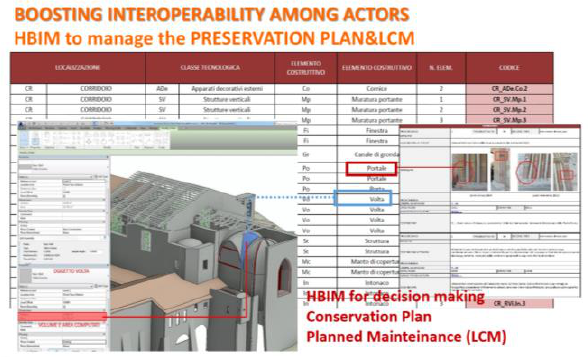
Figure 3. HBIM to support the Conservation Plan and Planned